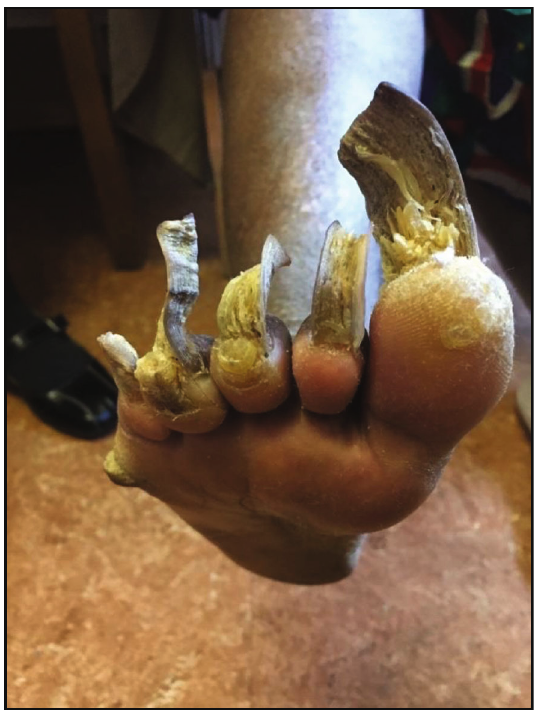
Figure 1: Plantar view of the patient ’ s right foot. Note the overgrown toenails and a visible callus